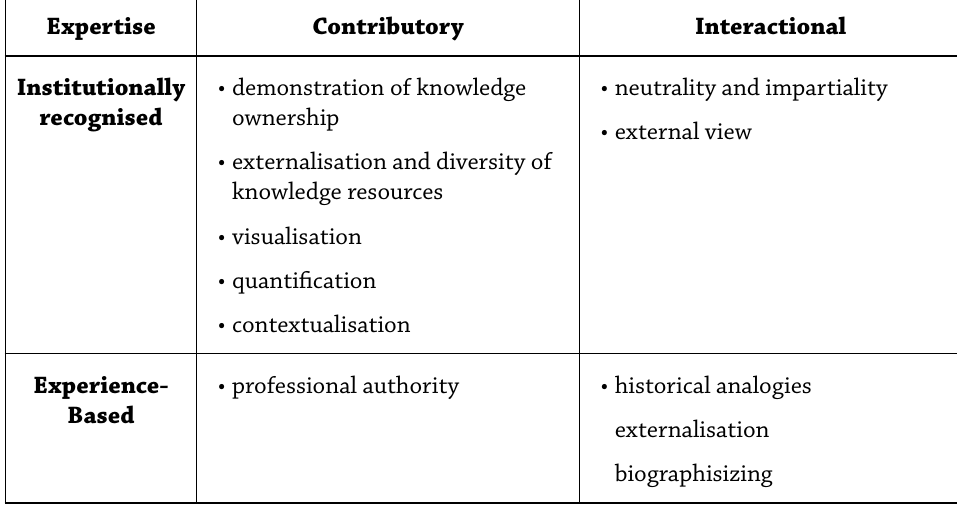
Table 2: Producing expertise